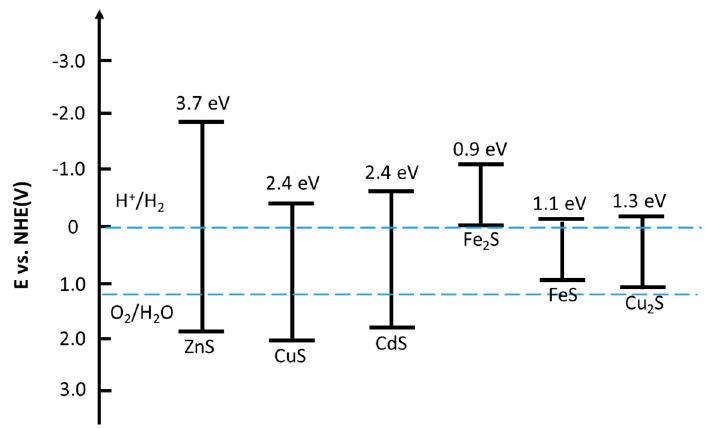
Figure 2. Schematic diagram illustrating the band gap, the potential energy of the conduction, and the valence band of promising metal chalcogenides.